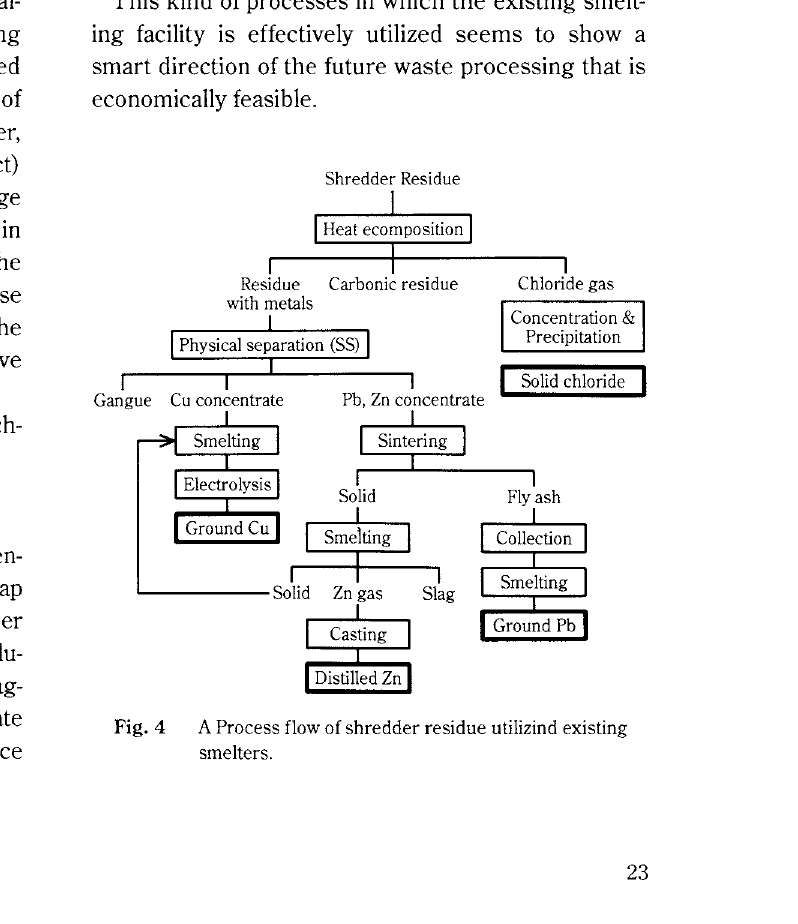
A Process flow of shredder residue utilizind existing